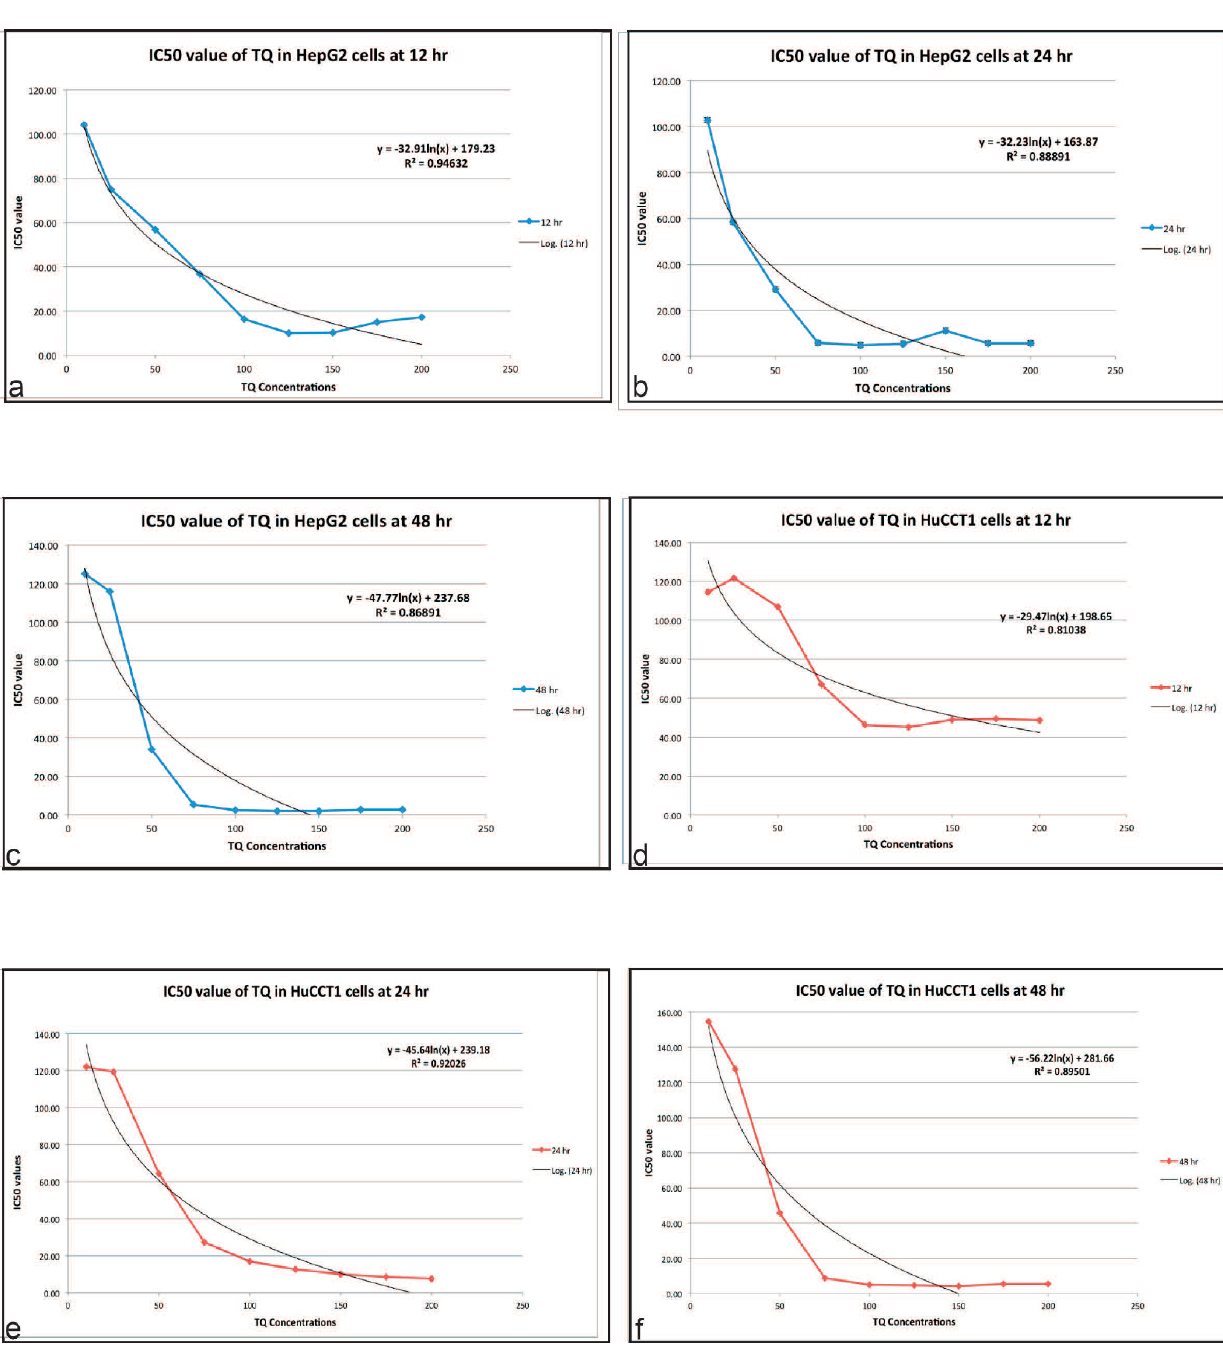
Figure 4. ( a – c ) IC 50 Values of TQ in HepG2 cells at 12, 24, and 48 h. ( d – f ) IC50 Values of TQ in HuCCT1 cells at 12, 24, and 48 h. IC 50 is a quantitative measure that indicates how much of a particular inhibitory substance is needed to inhibit, in vitro, a given biological process or biological component by 50%. IC 50 values are converted to the pIC 50 scale. Considering the minus sign, higher values of pIC 50 indicate exponentially more potent inhibitors. The values of IC 50 in both cell lines are quite similar. Additionally, pIC 50 is usually given in terms of the molar concentration (mol/L, or M), thus requiring IC 50 in units of M (h, hr: hour). Treatment of the HepG2 cell lines with TQ did not significantly accumulate cells in the cell cycle phases G1, S, or G2/M. The number of cells in the G1 and S phases decreased with higher doses of TQ. The percentage of cells in the G2/M phase increased after